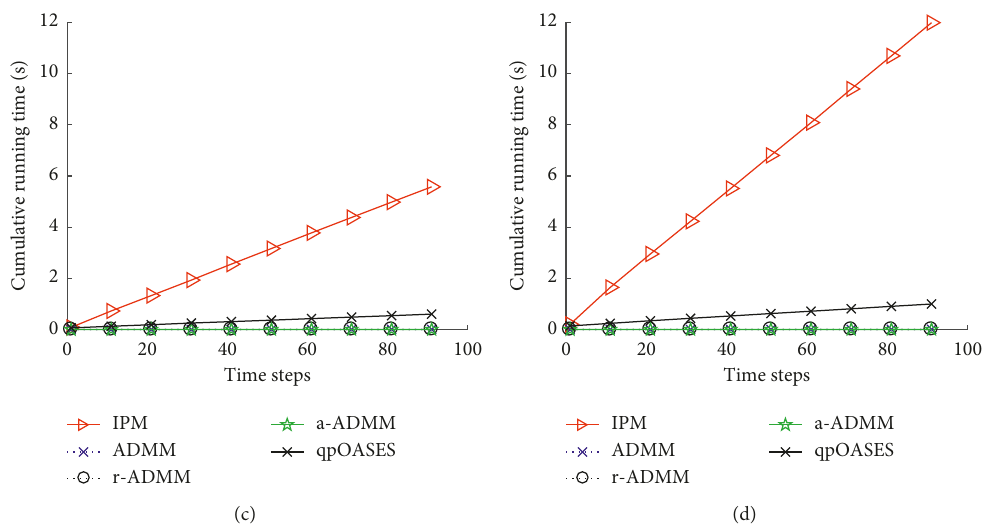
Figure 4: Real-time performance (running time on y -axis) versus number of time steps (time steps on x -axis) of IPM, qpOASES, ADMM, r-ADMM, and a-ADMM on UAV control task with N ranging from 10 to 40: (a) N � 10, (b) N � 20, (c) N � 30, and (d) N � 40.